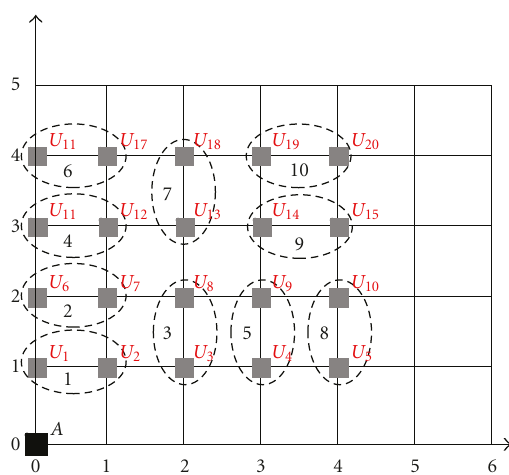
Figure 15: The detailed procedure of node localization sequence.